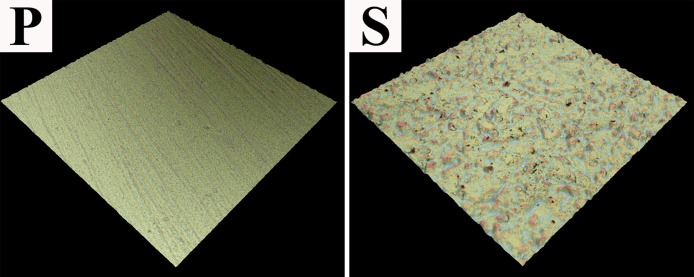
Representative 3-D images of sintered zirconia in group P and S.